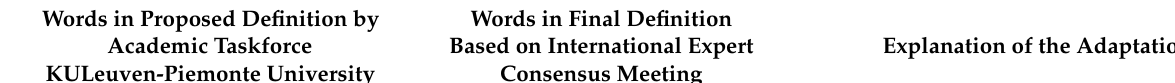
Table 1. Adaptations to the definition of second victim (SV) based on the